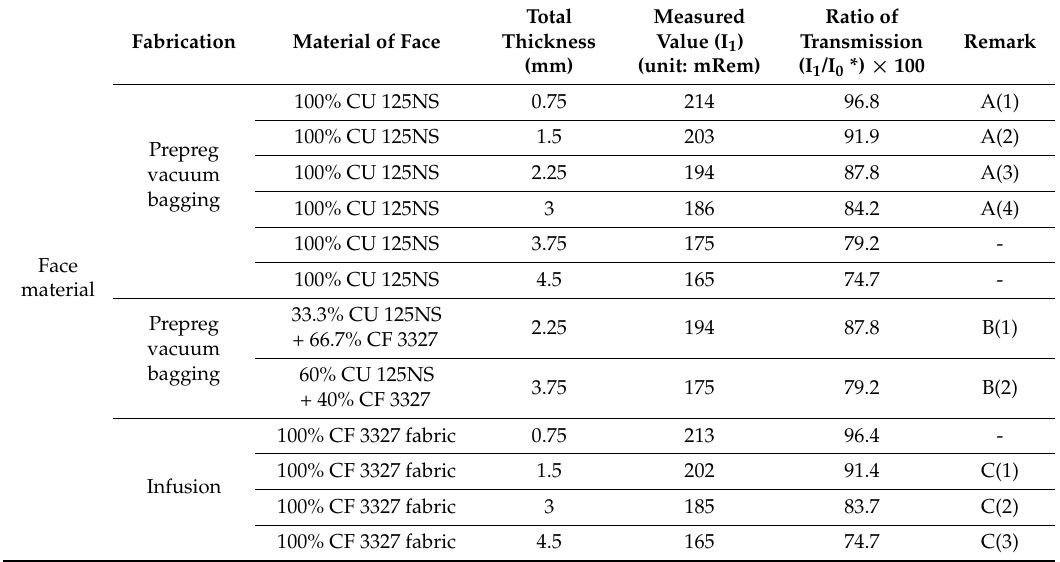
Table 3. X-ray Transmission ratio of CFRP.